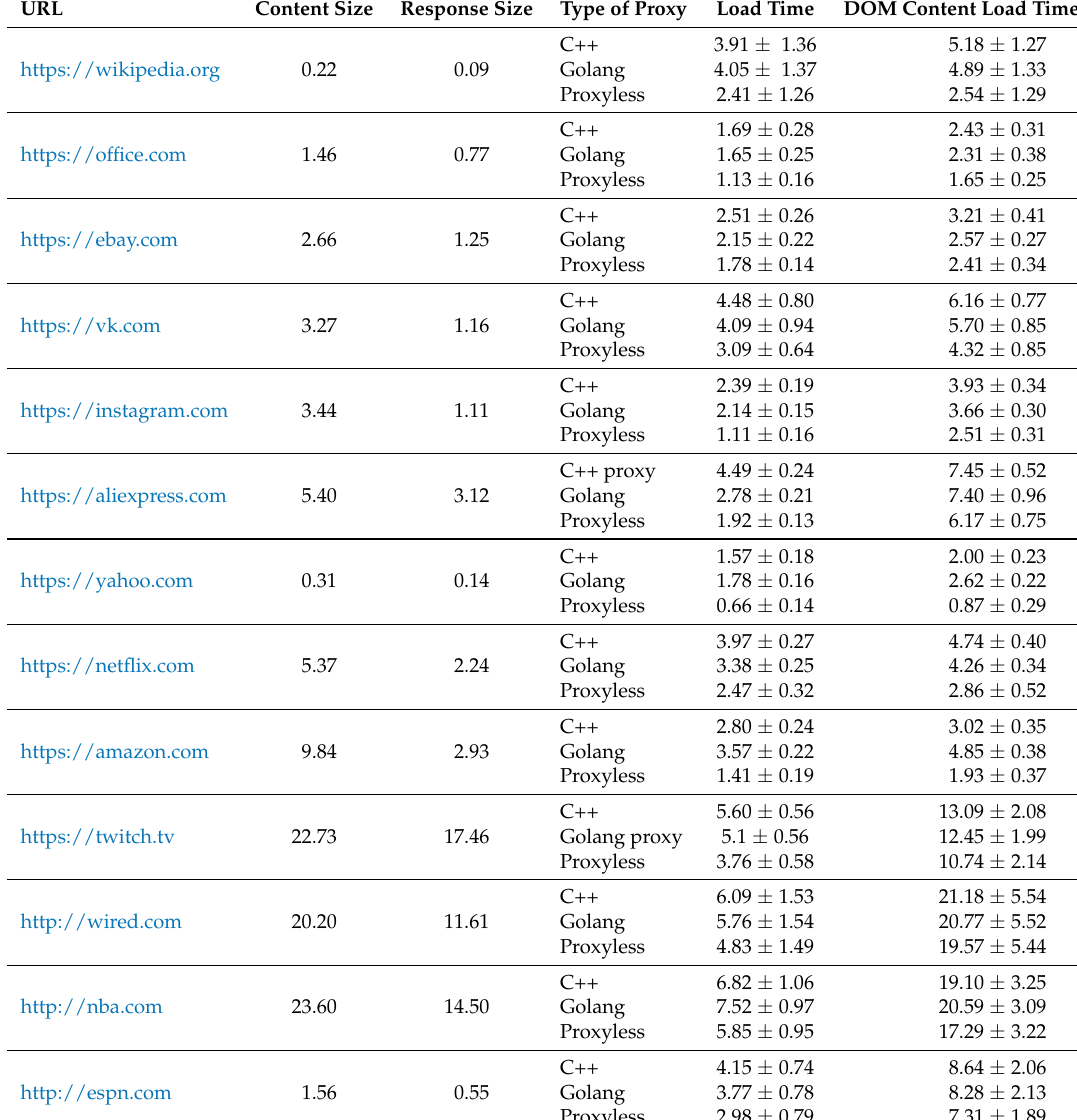
Table 2. Performance comparison of C++ and Golang proxy implementations vis-à-vis to the typical proxyless setting. Content and response current approximate sizes are in MB, while load times are in seconds and represented as a 95% confidence interval over 50 measurements done in different days and